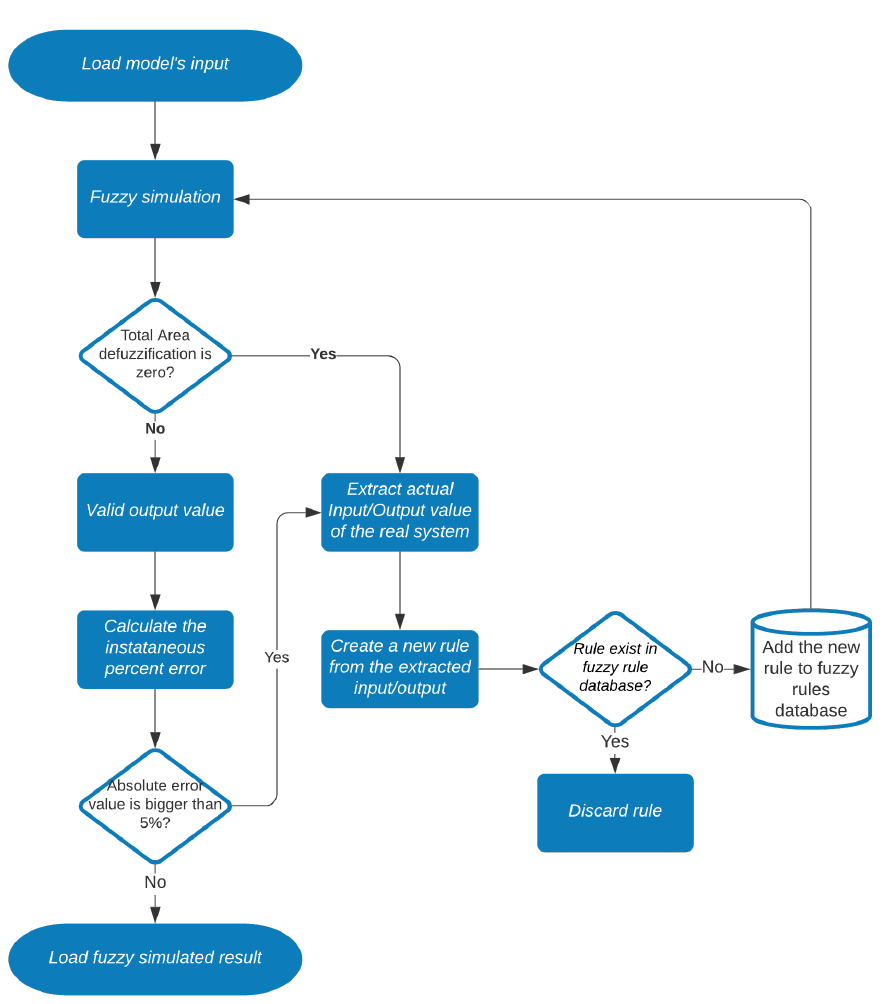
Figure 11. Flowchart of the fuzzy rules update algorithm.